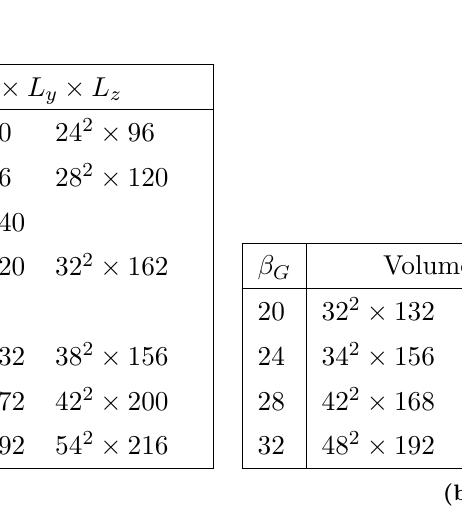
Figure 2. Unnormalized probability distributions of the expectation value h (cid:30) y measured on the lattice with varying (cid:12) G and converted to the corresponding continuum quantity. The histograms have been obtained by reweighting in T and minimizing the integrated probability di(cid:11)erence between the peaks. As (cid:12) G increases, the phases become more separated and thus the transition grows stronger. Con(cid:12)gurations between the two phases are suppressed exponentially by the free energy carried by the phase interface, with the suppression increasing with the area of the interface.